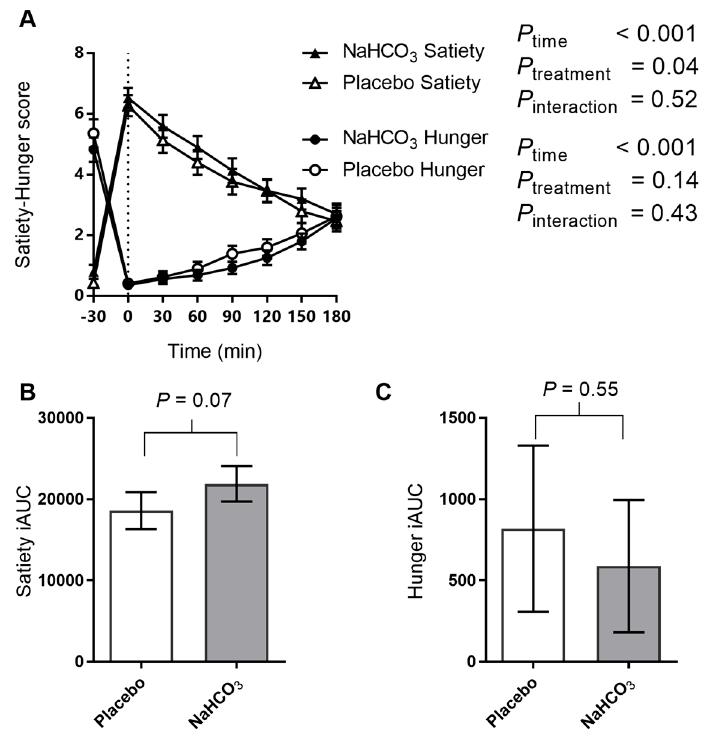
Figure 5. The effect of oral NaHCO 3 (1680 mg) administered prior to a high acid load meal on satiety and hunger scores ( A ); satiety iAUC ( B ); and hunger iAUC ( C ); comparing NaHCO 3 (solid symbol) and placebo (hollow symbol). Treatment was administered at t = − 30 min and the meal was completed at t = 0 (indicated by a dotted line). The effect of the treatment versus placebo on the postprandial outcome measure was tested by two-way repeated measure ANOVA and the difference in iAUC was tested by paired t -test, with p -values indicated on the graphs. All data presented as mean ± SEM.